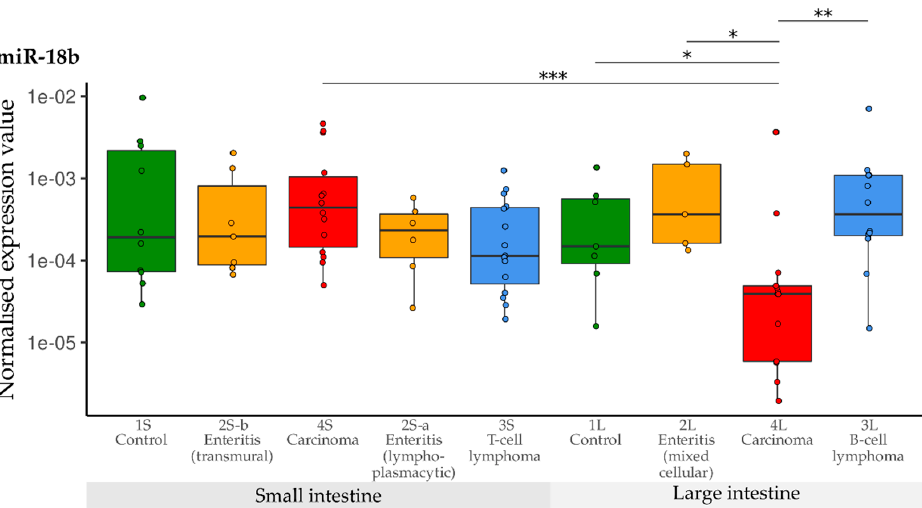
Figure 5. Expression levels of miR-18b in different groups (control, enteritis, carcinomas, lymphomas of the small and large intestine). The absolute miRNA copy number was related to the internal normaliser RNU6B. Results are shown as normalised expression values with a log10 scale. * p < 0.05, ** p < 0.005, *** p < 0.0005. Green control group, yellow enteritis, red carcinoma, blue lymphoma Compared with the controls, a significant down-regulation of miR-20b was observed in the group with small intestinal lymphoplasmacytic enteritis (2S-a), as well as in the group with small intestinal T-cell lymphoma (3S). Expression of miR-20b in the carcinoma group (4S) was significantly higher than in the groups with lymphoplasmacytic enteritis (2S-a) and lymphoma (3a)—but did not differ from the controls. Contrary to this, levels of miR-20b did not differ between any of the large intestine groups (1L, 2L, 3L, 4L) (Figure 6). Figure 6. Expression levels of miR-20b in different groups (control, enteritis, carcinomas, lympho- mas of the small and large intestine). The absolute miRNA copy number was related to the internal normaliser RNU6B. Results are shown as normalised expression values with a log10 scale. * p < 0.05, ** p < 0.005. Green control group, yellow enteritis, red carcinoma, blue lymphoma Levels of miR-192 were significantly lowered in the T-cell lymphoma group (3S) com- pared with all other small intestine groups (1S, 2Sa, 2S-b, 4S). Expression of miR-192 was again significantly decreased in all three large intestine groups (2L, 3L, 4L) compared with